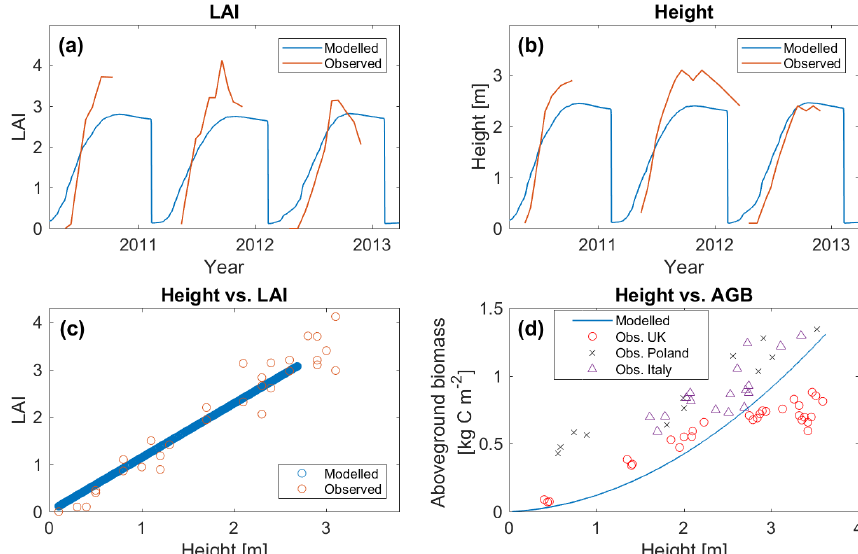
Figure 2. (a, b) Modelled leaf area index (LAI) and height of Miscanthus , compared against observations at Lincolnshire, UK, for the period 2010–2013. (c) Relationship between height and LAI, model compared against observations at Lincolnshire, UK. (d) Relationship between height and above-ground biomass (AGB), with the generic equation from the model compared against observations from the UK (Christian et al., 2008), Poland (Je˙zowski et al., 2011) and Italy (Cosentino et al.,